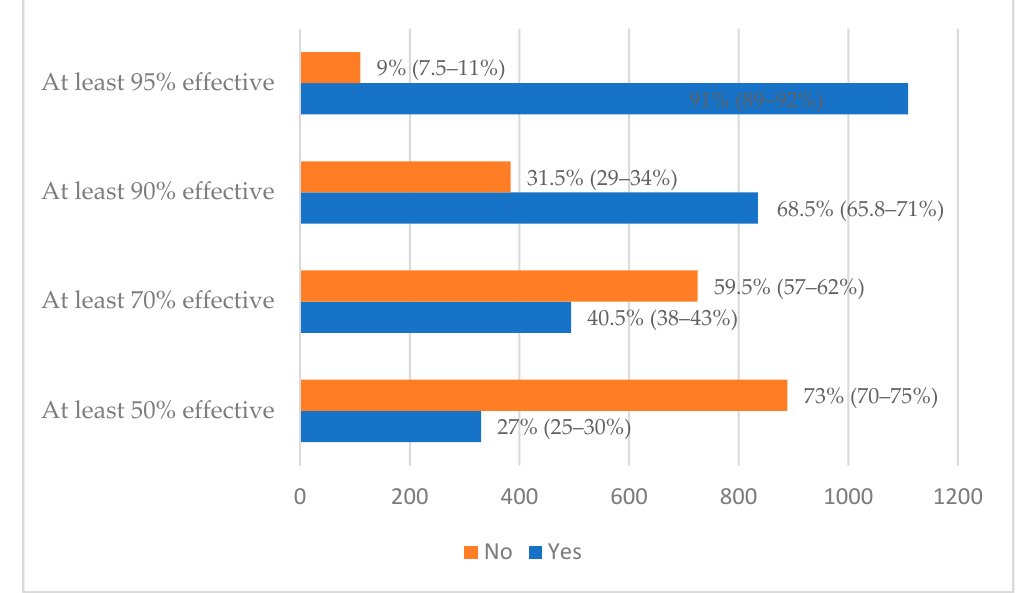
Figure 1. Acceptance rate of COVID-19 vaccine with confidence intervals. Six hundred and seventy-six (55.5%) participants indicated that they feared unforeseen side effects; 237 (19.4%) believed the vaccine was not effective (Figure 2).